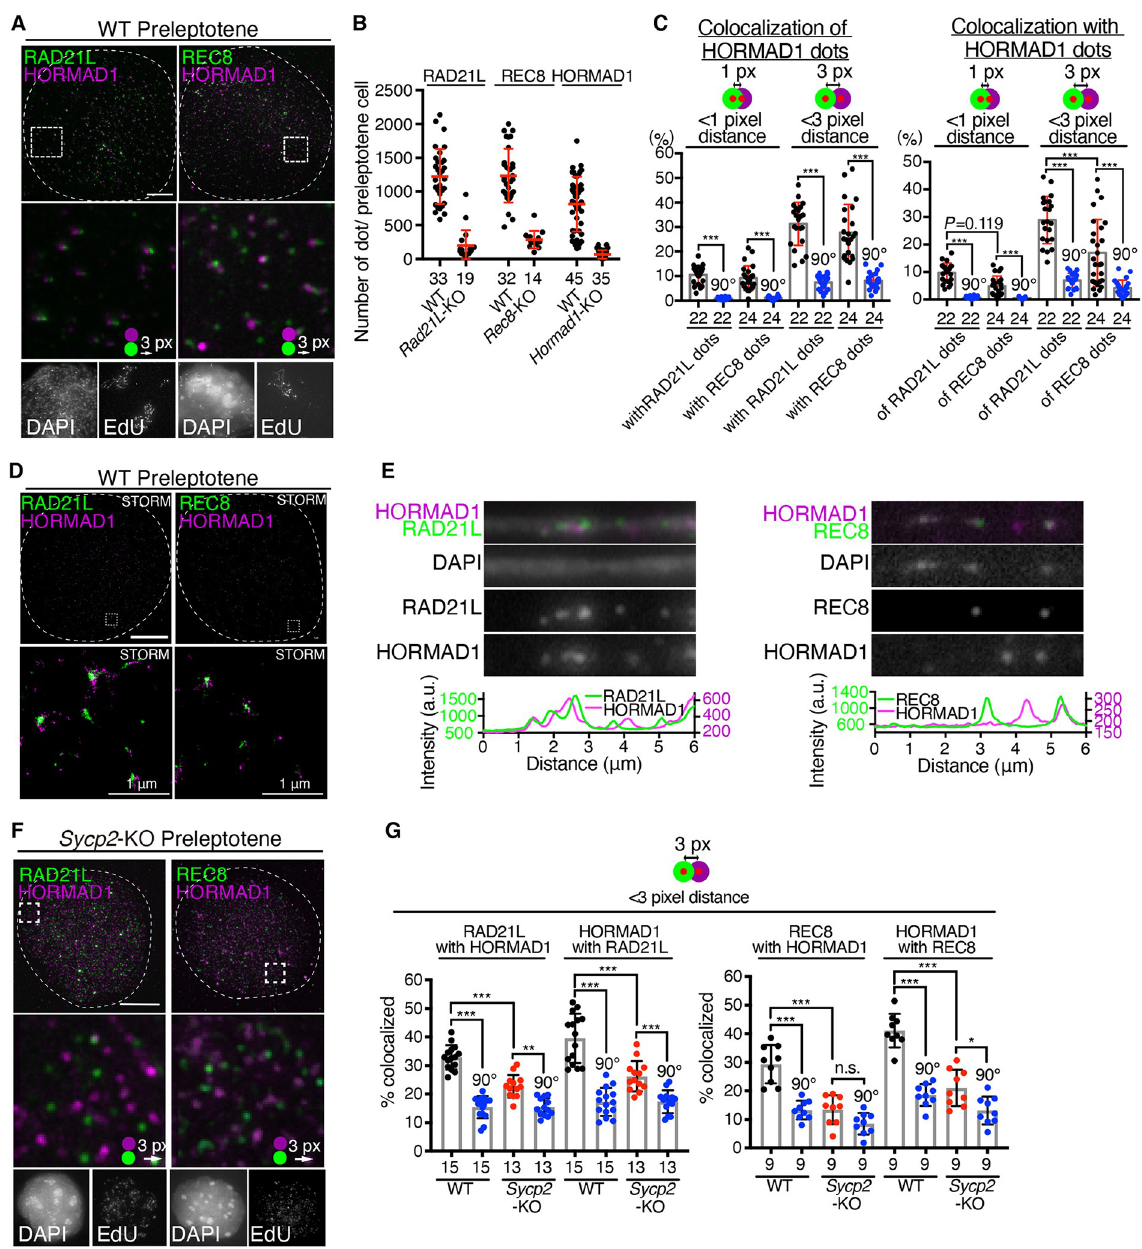
Fig 4. Partial colocalization of HORMAD1 with meiotic cohesins. (A) HORMAD1 was co-immunolabelled with RAD21L or REC8 on spread chromatin of WT preleptotene spermatocytes (upper). For visualization, green channels were shifted to the right by three pixels in the magnified views (middle). Preleptotene cells were identified by patchy EdU labelling pattern that represents late S phase (lower small panel) and by punctate cohesin staining. Note that slight difference in the localization pattern of RAD21L on the chromatin have been observed among previous studies [15,16,18,21]. This difference could be due to the sensitivity and/or cross reactivity with RAD21 of the antibodies used. (B) The number of the immunolabelled dotty signals of RAD21L, REC8 and HORMAD1 are shown in scatter plots. The numbers of the cells observed are shown below the graph. Red bars indicate mean and SD. (C) Quantification of HORMAD1 dots that overlapped with RAD21L or REC8 dots (left), and RAD21L or REC8 dots that overlapped with HORMAD1 dots (right) are shown in bar graphs with SD. To show these were not random overlaps, the co-localization was measured without (black plot) or with (blue plot) rotation of the HORMAD1 image by 90˚ clockwise relative to the cohesin images. Co-localization was measured by ComDet plugin for ImageJ (see Methods). Co-localization was assessed by two criteria, either < 1 pixel distance or < 3 pixel distance. Statistical significance was assessed by one-way ANOVA followed by Turkey’s multiple comparisons test with a single pooled variance. ��� : P < 0.001. The numbers of the cells observed are shown below the graph. Red bars indicate SD. (D) Super-resolution imaging of spread chromatin using N-STORM microscopy showed that HORMAD1-enriched domains